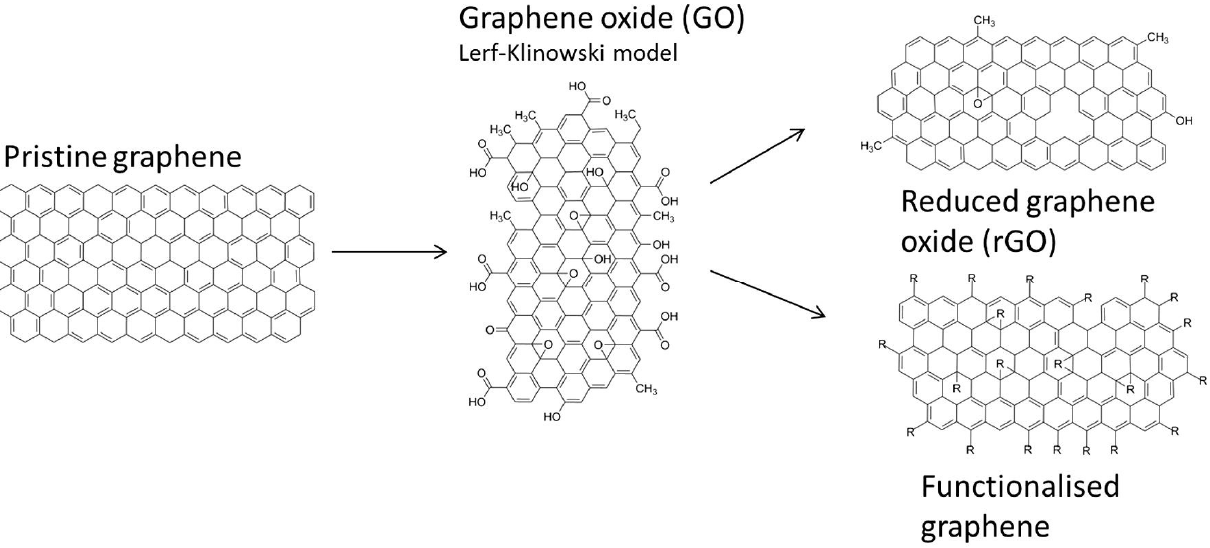
Figure 1. Structure of pristine graphene, GO, rGO, and functionalised graphene. Sourced and adapted with permission from Ref. [17].